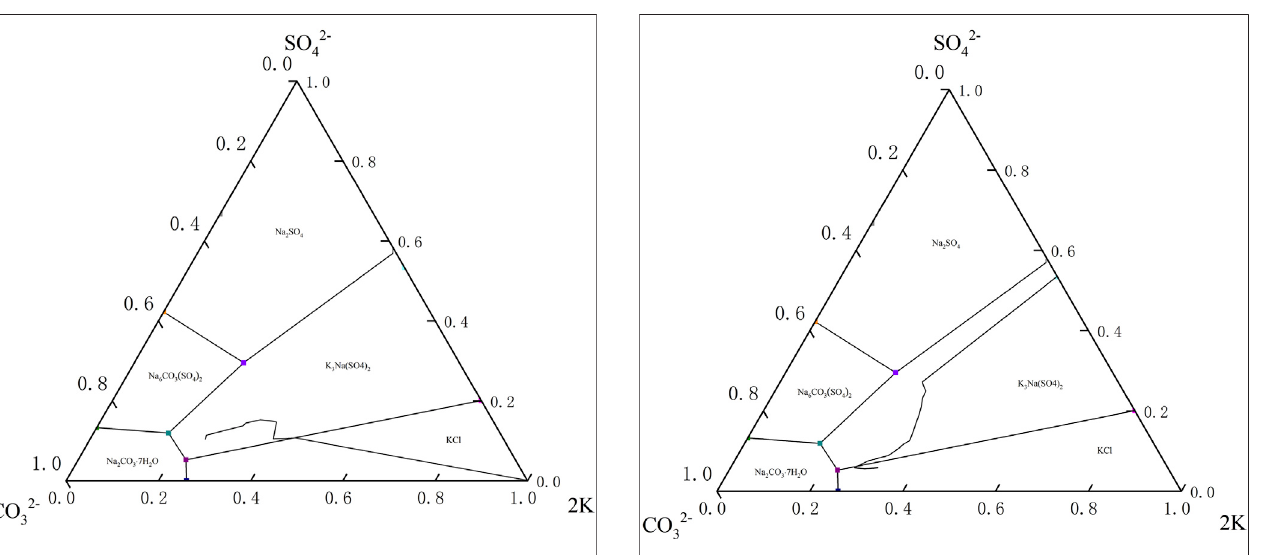
Frontiers in Earth Science |